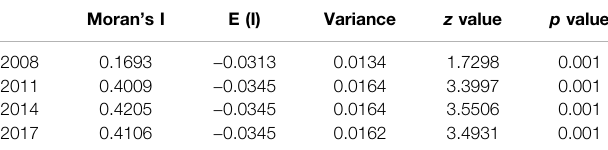
TABLE 4 | Global Moran ’ s I index of UCCD.